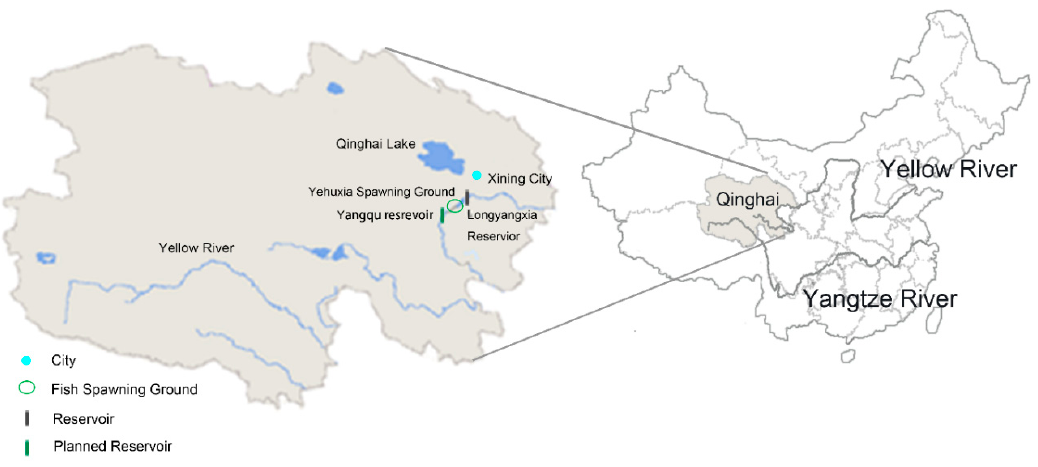
Figure 1. Study Figure 1. Study area.